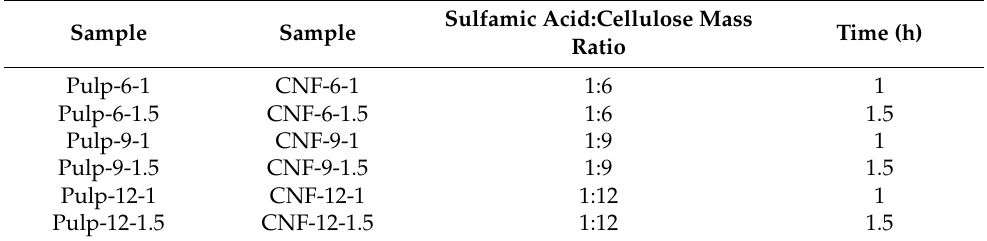
Table 2. Pretreatment conditions of cellulose in sulfamic acid and glycerol DES.